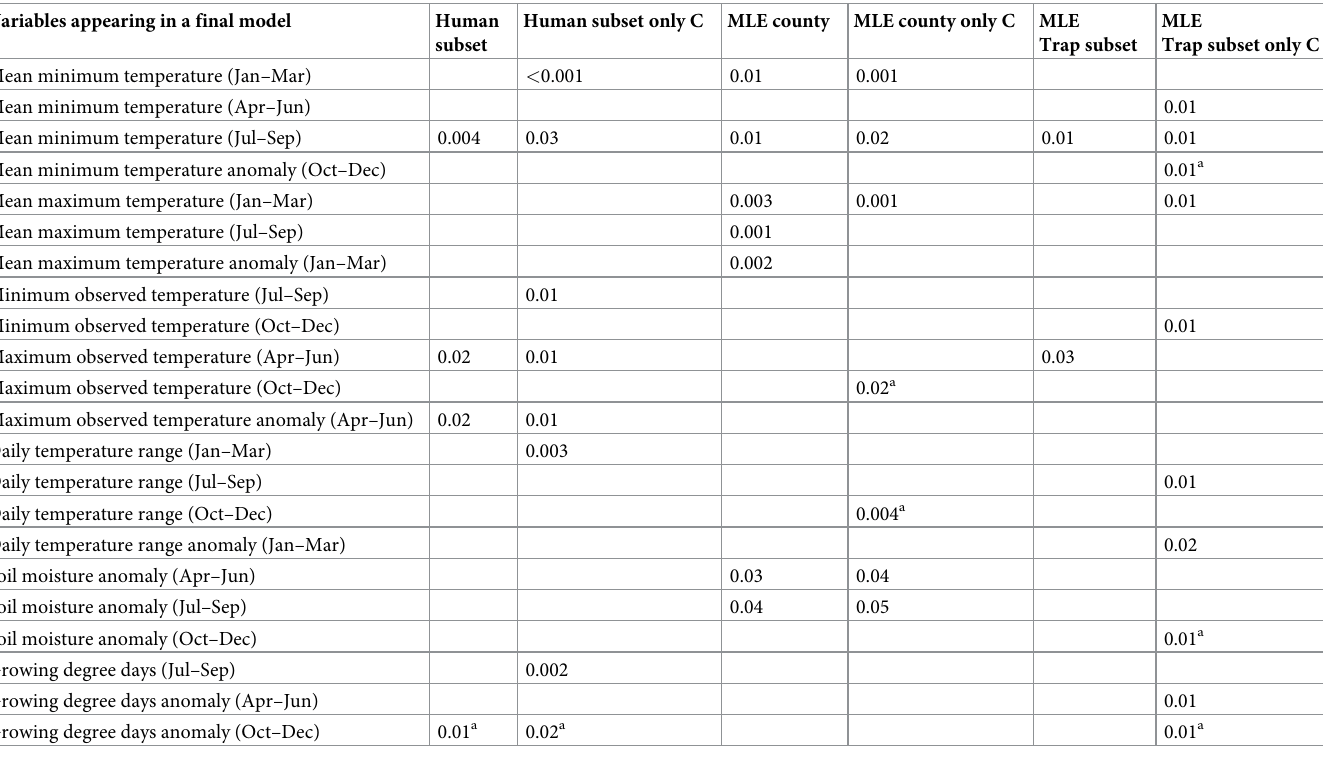
Table 4. Climate variables identified as important by the random forest model when the model with all covariates was run, and when a model with only climate covariates was run (only C). Model results are presented for human cases in those counties where mosquito surveillance data were collected, and for mosquito infection rates ( MLE ) at both the county and trap scales. Values in the table indicate the amount of unique variation explained by the variable using variance partitioning, while a blank indicates that the variable was not included in the final predictive model.